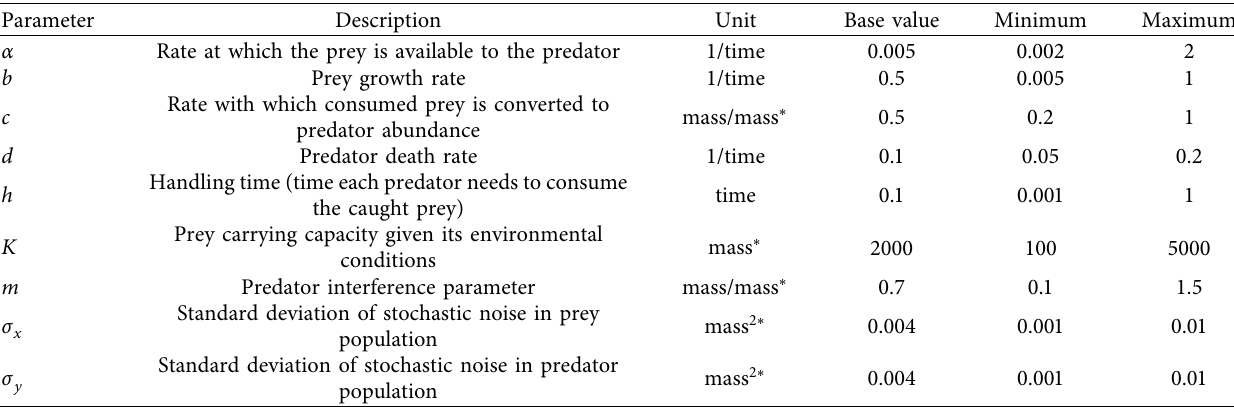
Table 1: Description, values in the assumed state of the world (SOW), and ranges of sampled uncertain model parameters. The fishery harvesting plans are optimized to a system assumed to be described by the base values and then re-evaluated in 4,000 alternative SOWs generated by a Latin Hypercube Sample across the parameter ranges listed in the table (minimum and